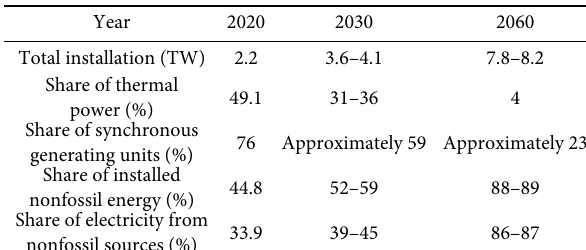
Fig. 4 Predicted power-supply installation development. Table 2 Predicted development of China’s overall power